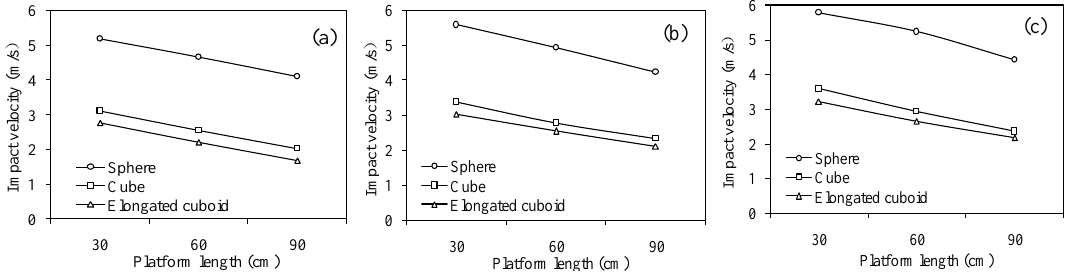
Figure 12. Influence of platform length on the impact velocity of rockfalls of different shapes and weights: (a) 6kg, (b) 5kg, and (c) 4kg.